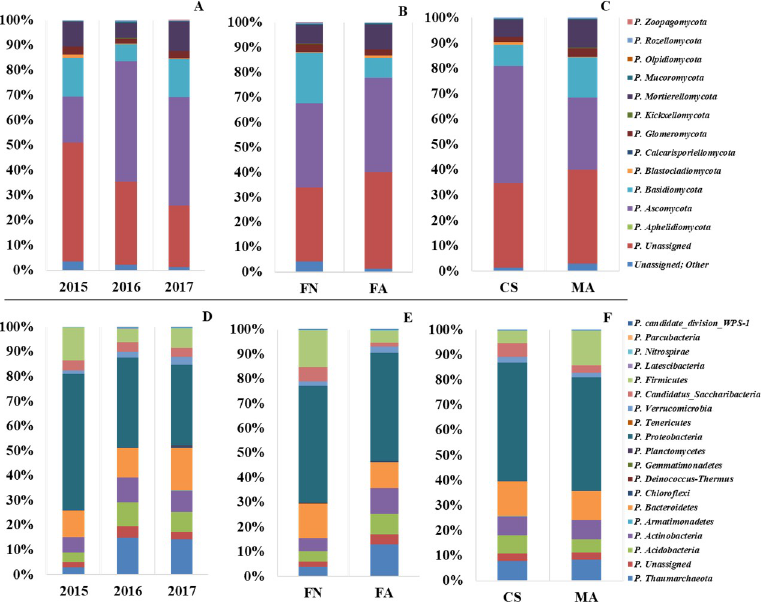
Fig 3. Average relative abundance of the most dominant microbial communities according to the vintage, vineyard location and cultivar. Identified fungal communities classified by (A) vintage year, (B) vineyard location and by (C) cultivar. Identified prokaryotic communities’ classified by (D) vintage year (E) vineyard location and (F) cultivar. Only the communities with abundance > 0.1% are